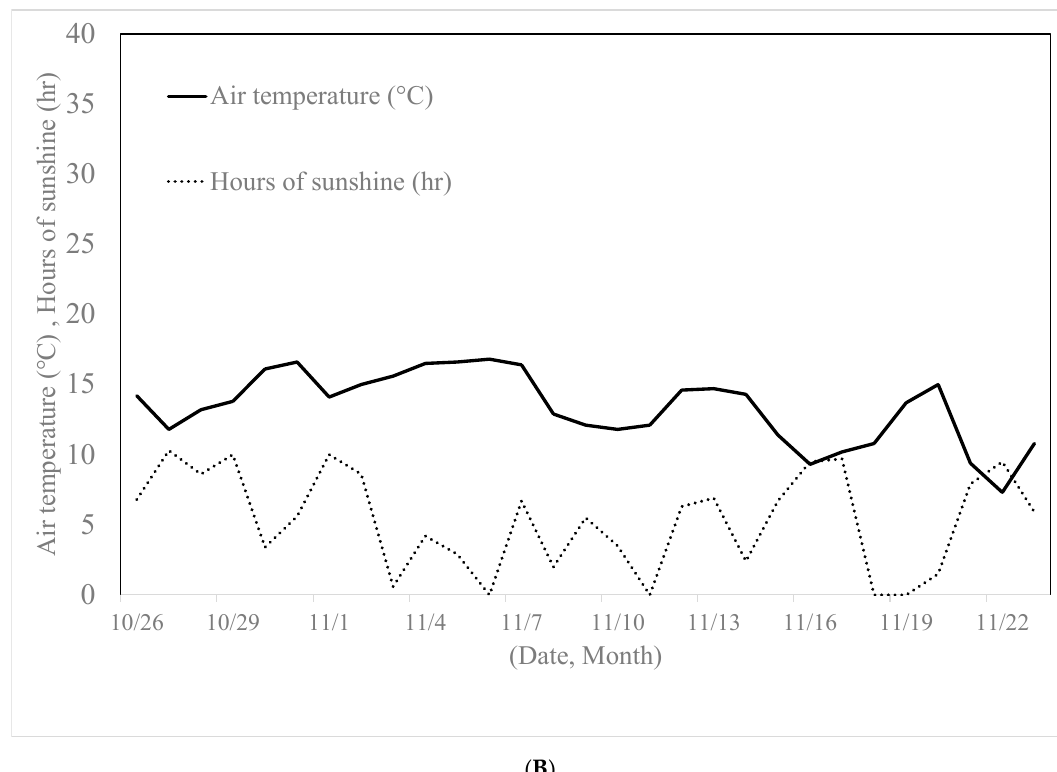
Figure 1. Changes in air temperature and hours of sunshine at the Tsuchiura observation point of the Automated Meteorological Data Acquisition System, The Meteorological Agency, Japan. ( A ): Summer, ( B ): Autumn.